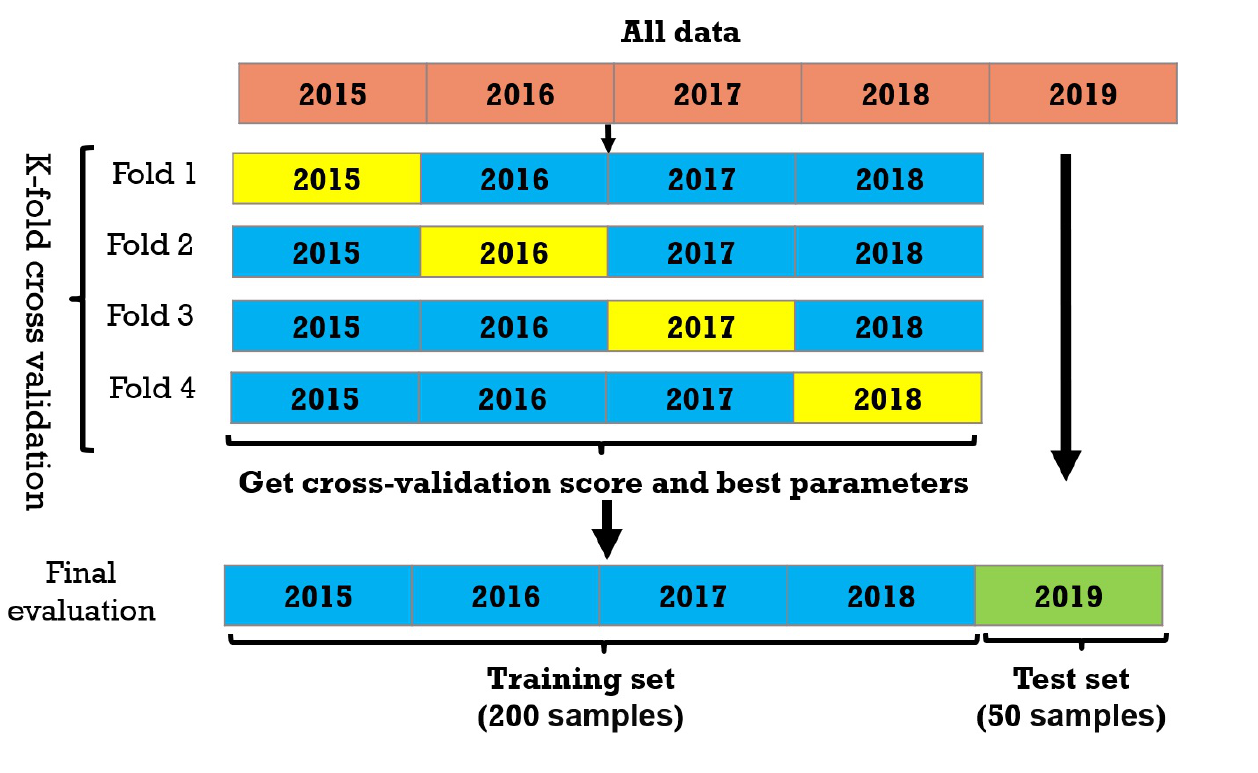
Figure 8. Cross-validation and parameters